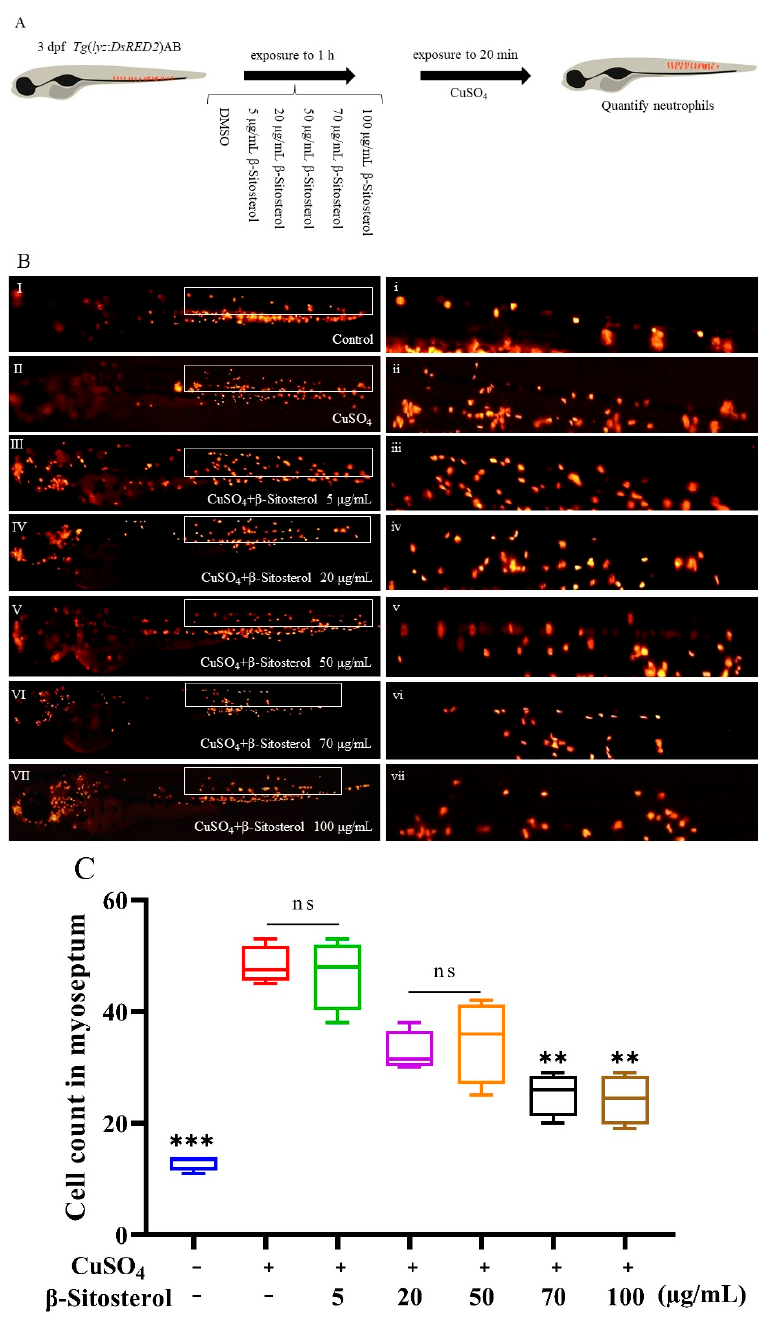
Figure 5. Effect of β -sitosterol on CuSO 4 -induced inflammatory response in zebrafish: ( A ) flowchart of the experiments; ( B ) neutrophil migration in zebrafish after treatment; ( C ) quantification of the number of neutrophils aggregated at the lateral line after CuSO 4 treatment. Data are expressed as the mean ± standard deviation. ns, no statistical significance, ** p < 0.01, and *** p < 0.001 compared with the group treated with CuSO 4 alone ( n = 4).